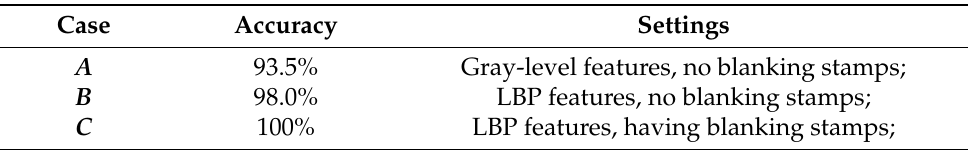
Table 2. The control accuracies of the motor on the simulated videos in the different settings. Here, the LBP indicates Local Binary